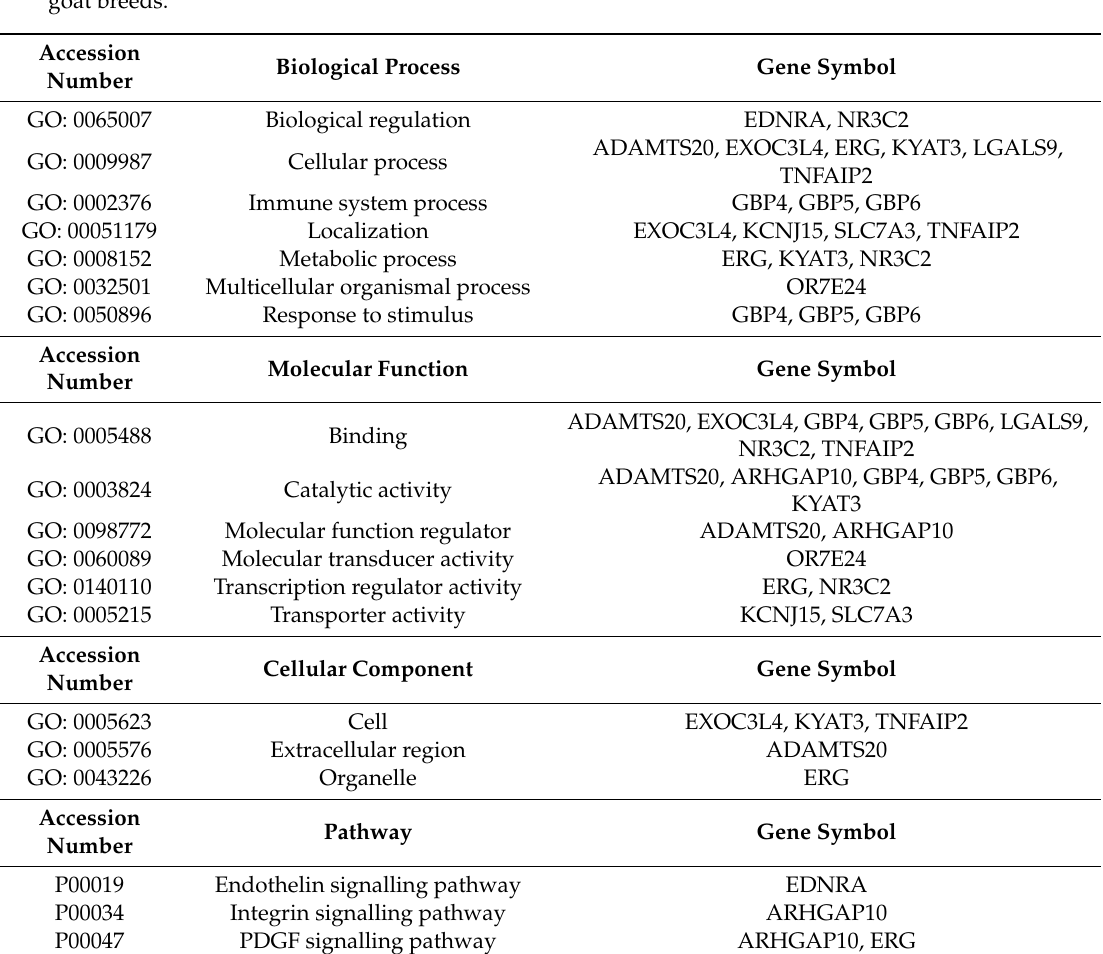
Table 2. The gene ontology (GO) categories (biological process, molecular function, and cellular component) and pathways containing genes overlapping the most frequent CNVRs identified in Sicilian goat